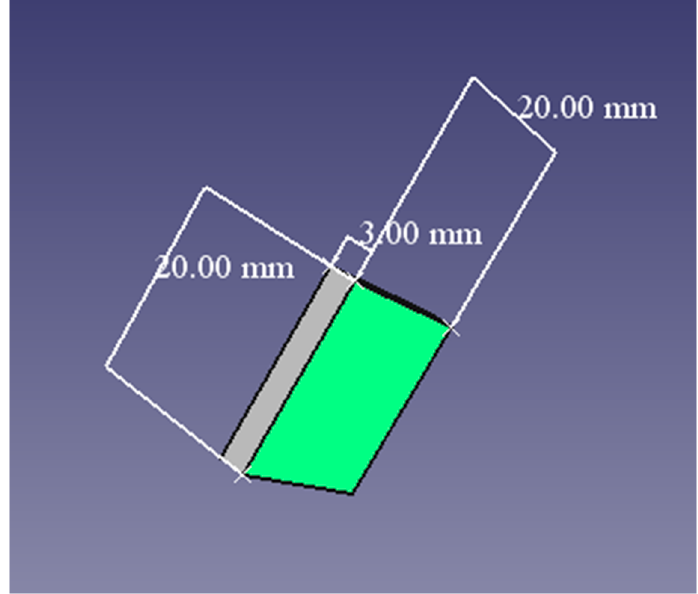
Figure 1. Graphic of the specimens’ design and dimensions.